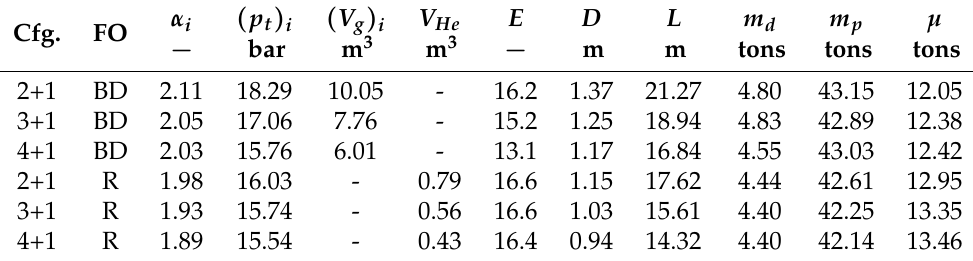
Table 9. Hybrid engine design and performance: manned mission. The first column (Cfg.) reports the launcher configuration, e.g., 2+1 stands for two engines in the first stage and one engine in the second stage. The second column reports the feed system, blow down (BD) or regulated (R). D and L are engine diameter and length. m d is the engine dry mass and m p is the propellant mass.